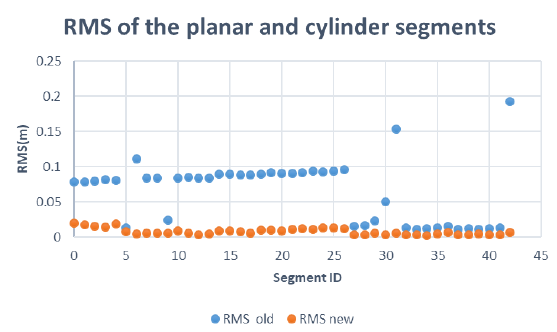
Figure 6. RMS before and after update